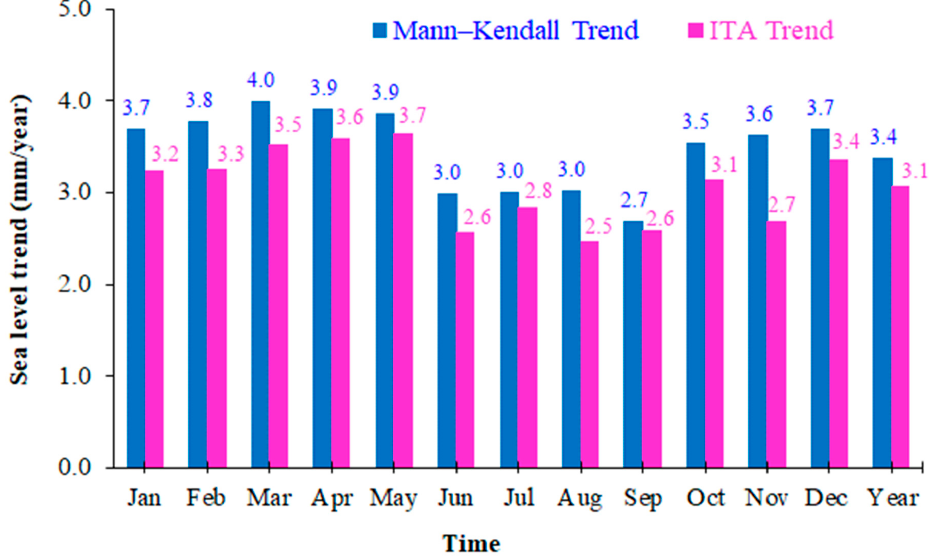
Figure 12. SLR trends of Mann–Kendall and ITA methods at the Hon Dau station for 1961–2020.